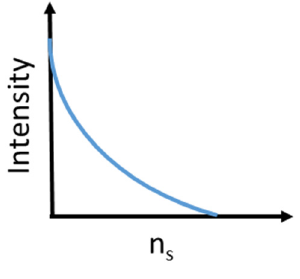
Figure 5. Mean gray value (GV) as a function of the sample refractive index in the interval [1, 1.43]. Inset shows the mean GV in the RI range [1.333, 1.358]. Dashed red lines represent data fits.